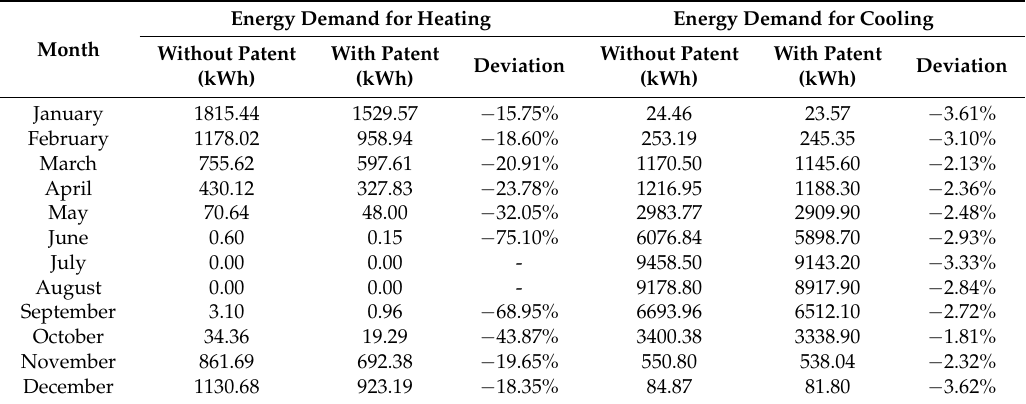
Table 6. Differential of energy demand between the case study without patent and the one with patent for the period of 2020.